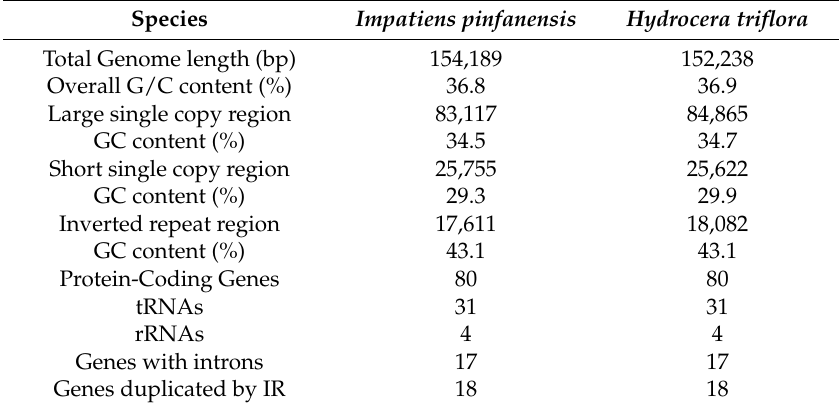
Table 1. Comparison of the chloroplast genomes of Impatiens pinfanensis and Hydrocera triflora . Species